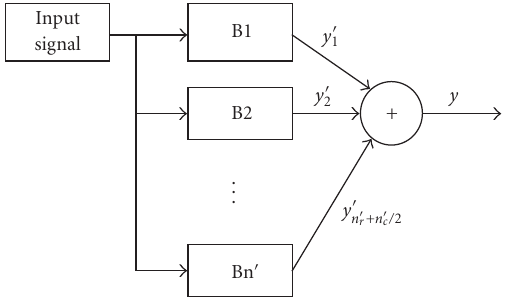
Figure 2.2. Plant decomposition into as many blocks as it has di ff erent